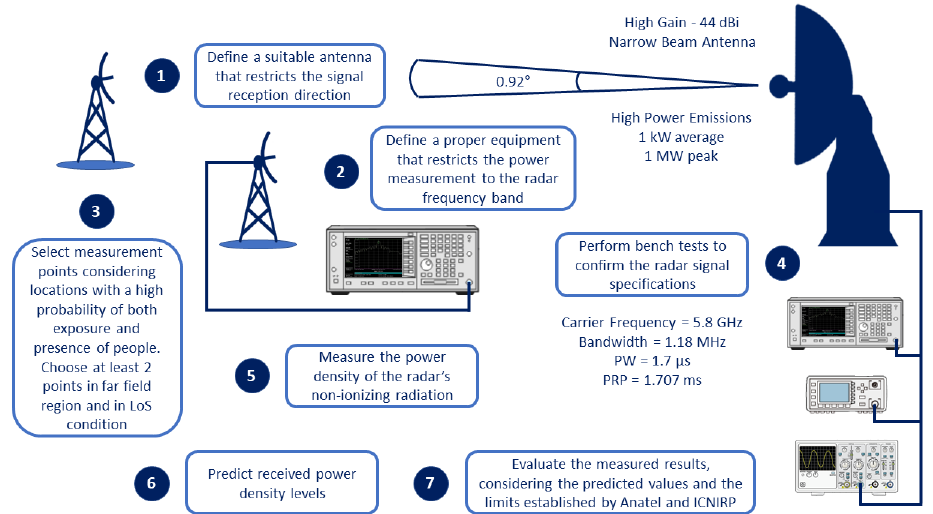
Figure 1. Flowchart of non-ionizing radiation measurement methodology for trajectography